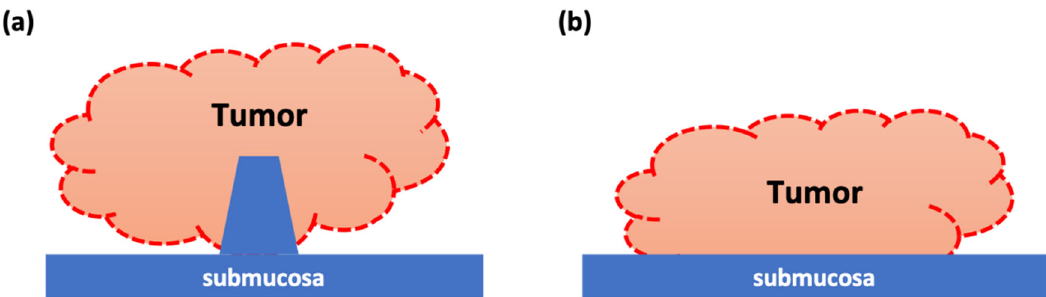
Figure 5. Schematic diagram of bladder cancer. Bladder cancer (BC) with inchworm sign has a submucosal stalk ( a ), whereas BC without inchworm sign does not ( b ). Therefore, for tumors of the same size, the surface area of the tumor protruding into the bladder lumen is larger in BC with inchworm sign (red dashed line).